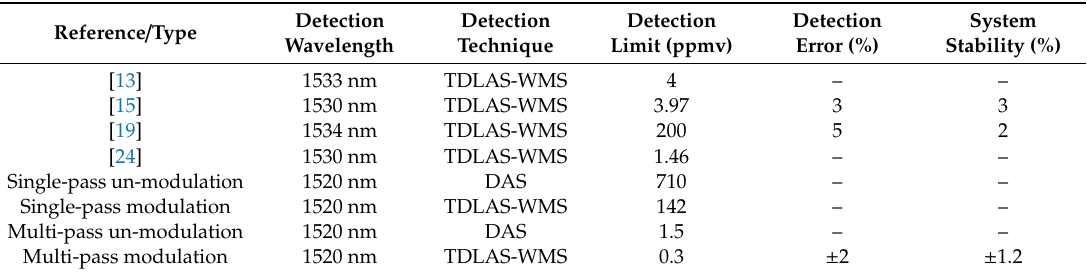
Table 1. Performance comparison between the proposed C 2 H 2 detection system and the reported C 2 H 2 detection